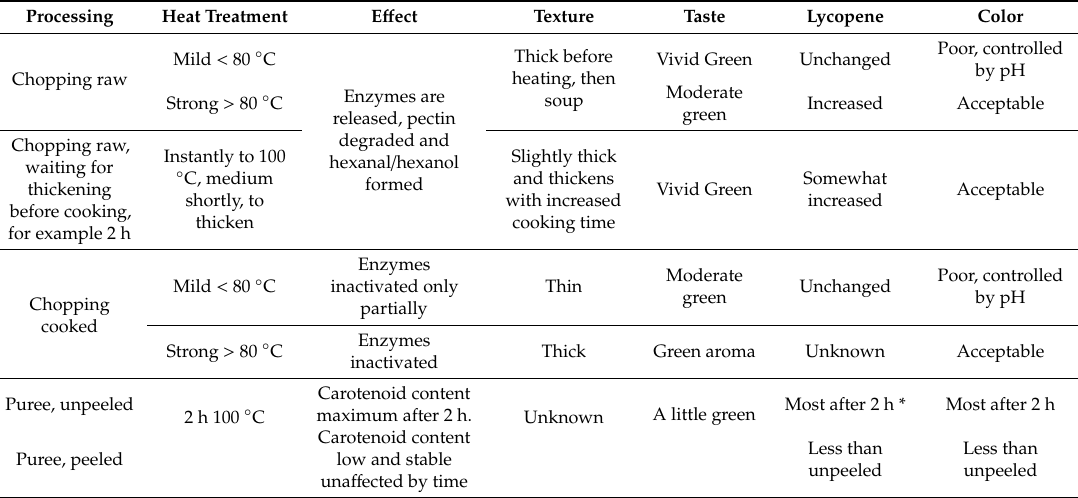
Table 3. E ff ects of heat treatment on tomato products.